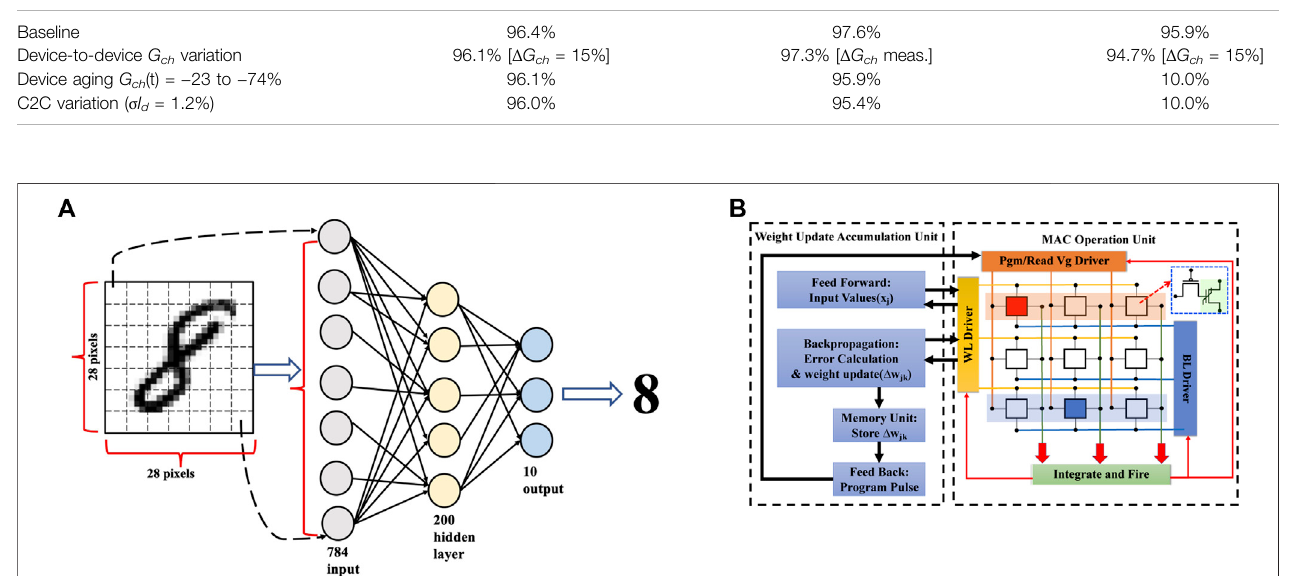
FIGURE 7 | (A) Multi-layer perceptron architecture considered during neuromorphic simulation in the CIMulator platform. The network consists of an input layer with 784 nodes, one hidden layer with 200 nodes, and an output layer with 10 nodes. (B) Deploying Fe-FET as an analog synaptic memory array in a simple single layer